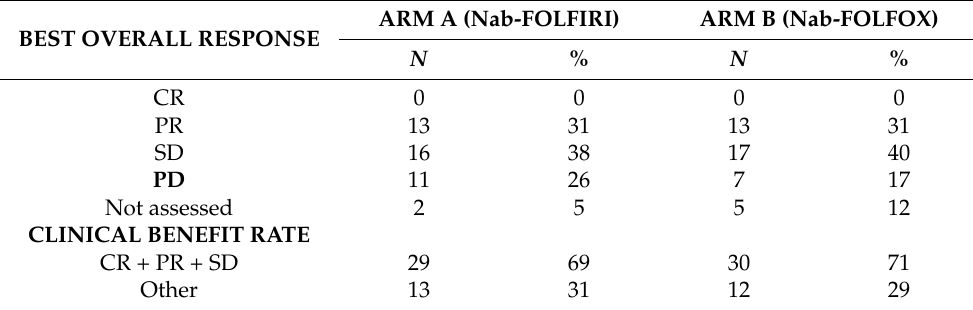
Table 5. Most relevant grade 3 or 4 adverse events and historical controls. NR: not reported. Phase II: Most Relevant Grade 3 or 4 Adverse Events and Historical Controls.